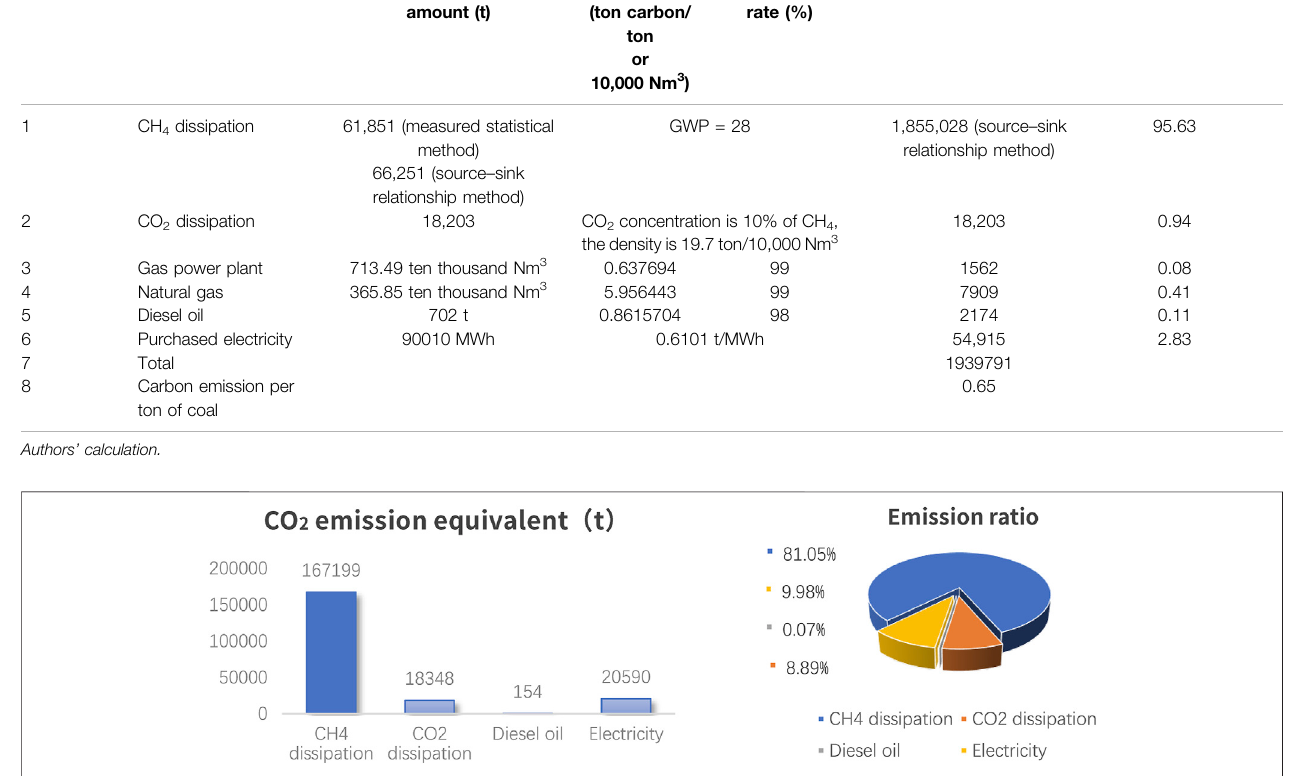
FIGURE 6 | Carbon emission by source and emission proportion of Lingzhida coal mine.